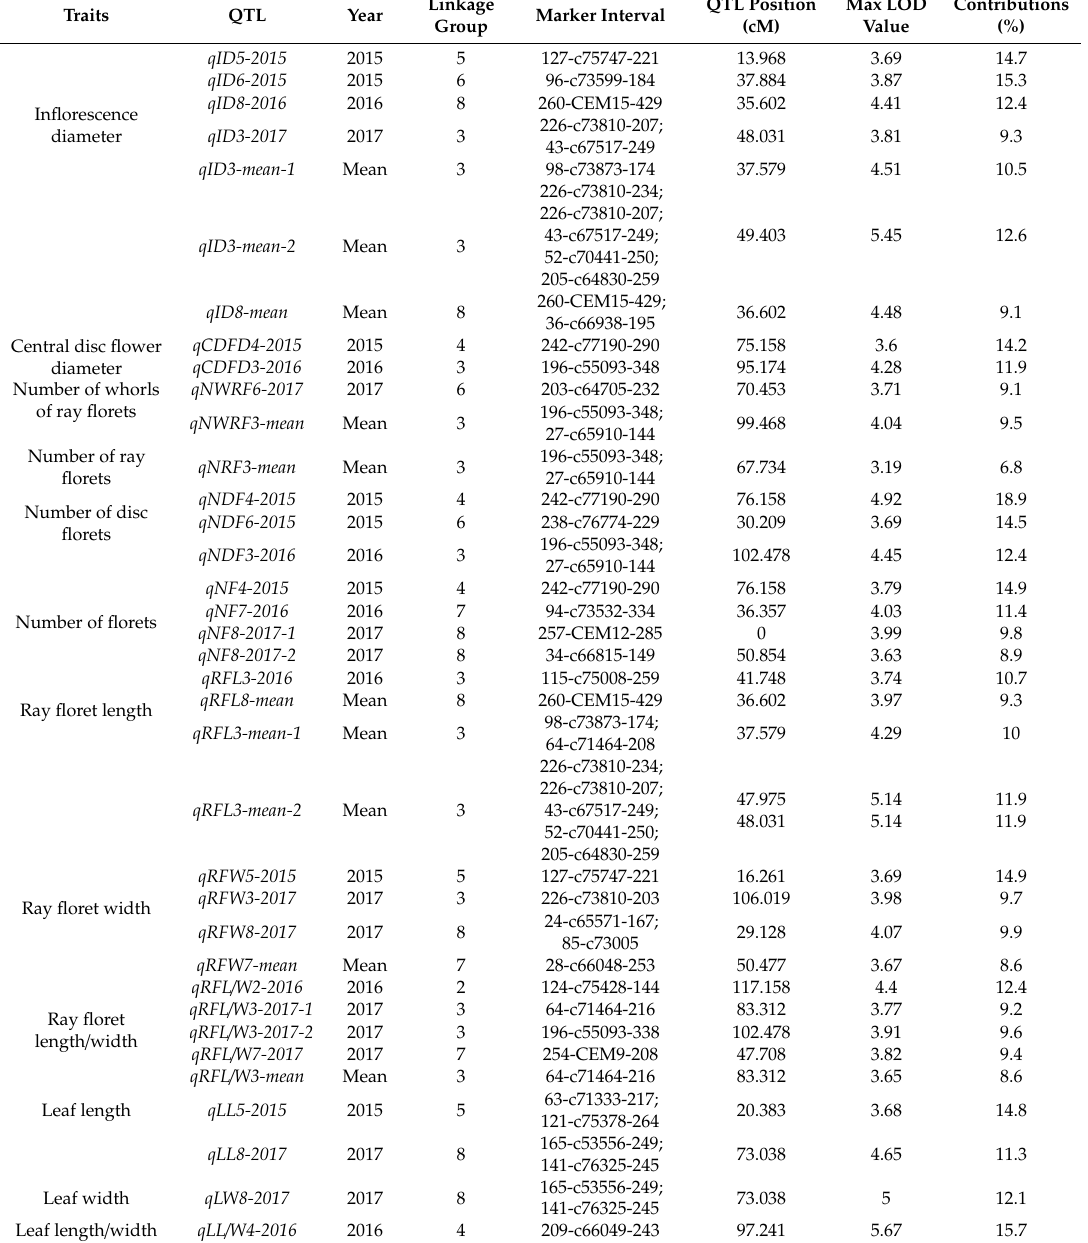
Table 4. Characterization of QTLs for inflorescence and leaf traits in